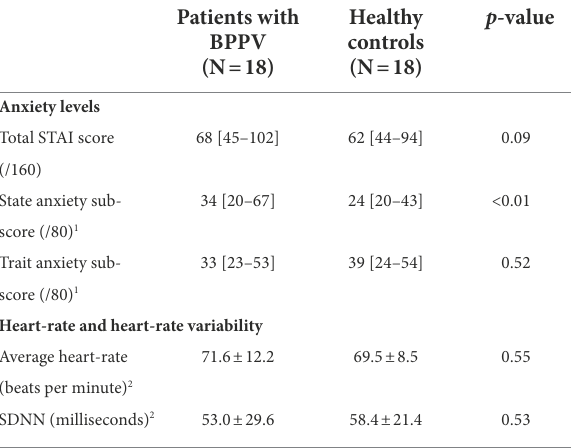
TABLE 2 Anxiety levels, heart-rate and heart-rate variability measures in patients with BPPV in comparison with healthy controls. Patients with BPPV